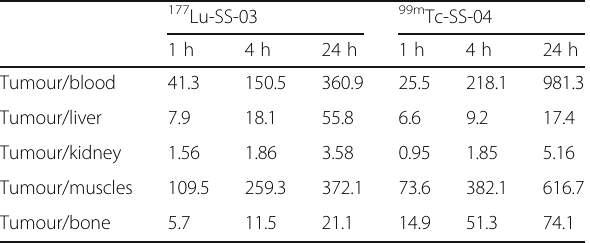
Table 4 Tumour-to-normal tissue ratios of 177 Lu-SS-03 and 99m Tc-SS-04 after 1, 4, and 24 h of administration in nude mice bearing HEK293-rsst2 tumour xenografts